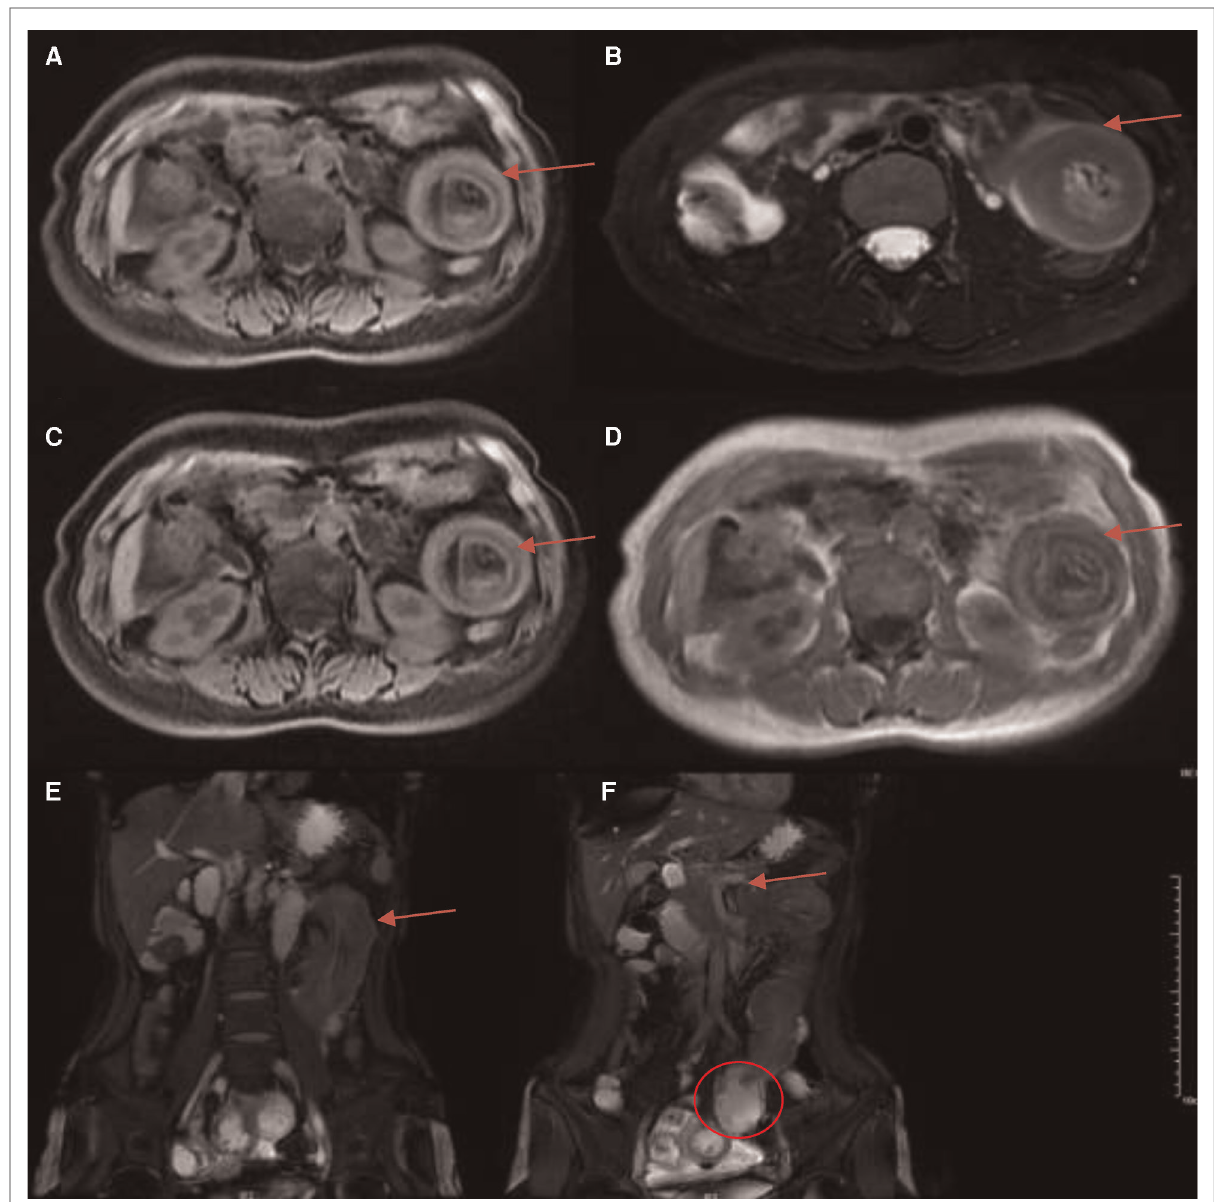
FIGURE 2 Magnetic resonance imaging (MRI) demonstrated jejunal intussusception of the left-sided upper abdomen with concentric circle-like changes. ( A ) T1 FS (arrow); ( B ) RTr OAx T2 fs (arrow); ( C ) WATER: Ax LAVA-Flex (arrow); ( D ) InPhase: Ax LAVA-Flex (arrow); ( E ) BH Cor 2D Fiesta Shim showed the intussusception of the long segment of jejunum from the pelvis to the left-sided upper abdomen, with concentric circle-like changes about 14.2 cm (arrows); ( F ) BH Cor 2D Fiesta Shim showed the thickening of the proximal jejunum intestinal wall with the thickest part about 2.6 cm, and the lumen was narrowed with peripheral exudation (arrow). The distal segment of the jejunum and ileum were dilated, with fl uid accumulation and slightly thickened walls